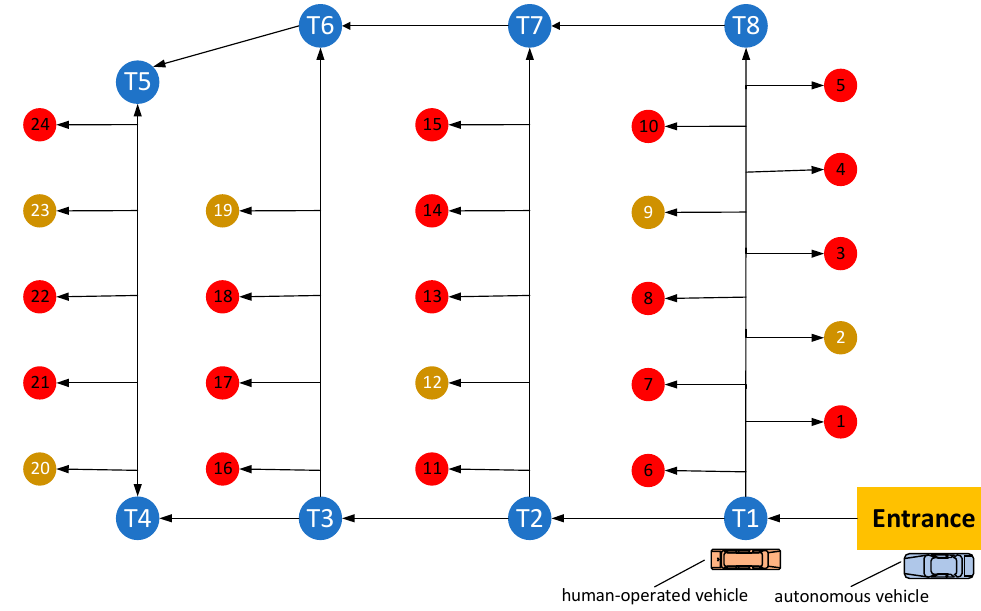
Figure 7. Example of a parking scenario 2.